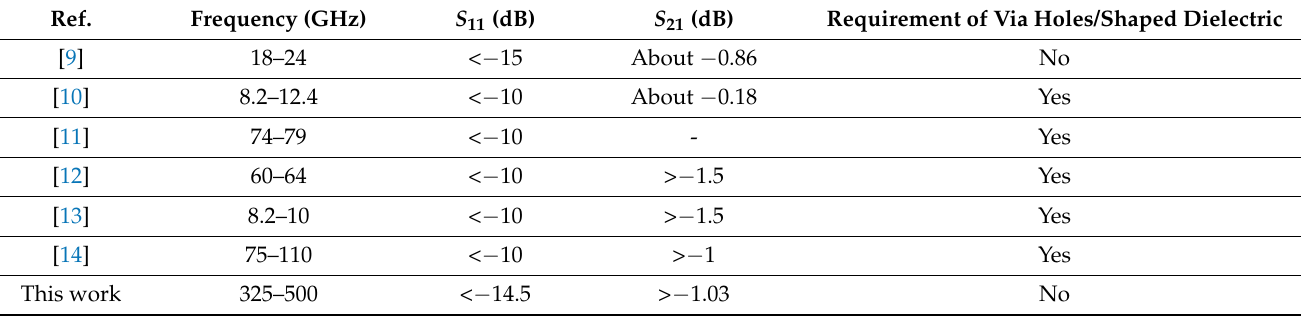
Table 2. Comparisons between different H -plane MSL-to-RWG